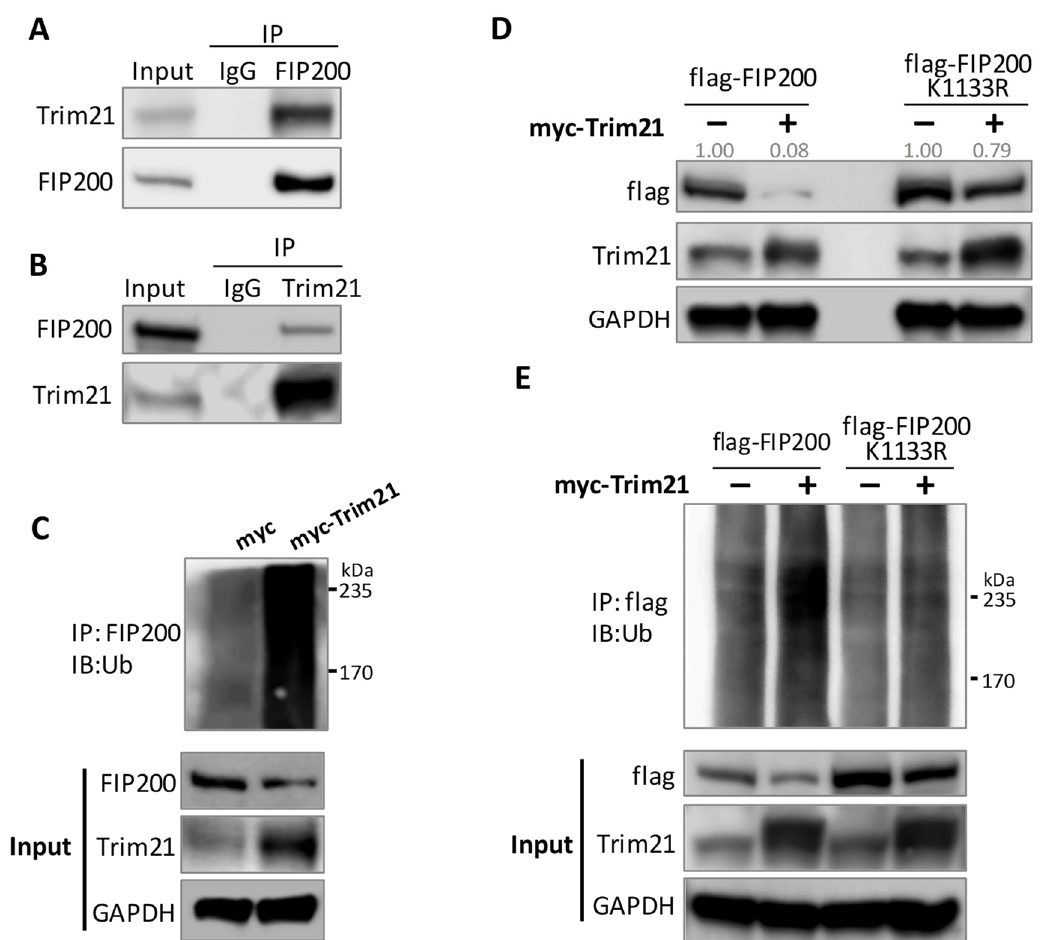
Figure 5. Trim21 ubiquitinates FIP200 for degradation. ( A , B ) Co-IP assay demonstrated interaction between endogenous FIP200 and Trim21. Anti-FIP200 Ab ( A ) or anti-Trim21 Ab ( B ) was used for immunoprecipitation. The mutual pulldown was detected by immunoblot. ( C ) Ubiquitination assay indicated Trim21 overexpression increased FIP200 ubiquitination level. HeLa cells were transfected with His-Ub and indicated plasmids. ( D ) Effect of the K1133R mutation on Trim21-induced FIP200 degradation was determined by immunoblot. HeLa cells were transfected with indicated plasmids. Here, a 3-fold amount of flag-FIP200 plasmid was transfected compared to the amount of K1133R mutant. Flag-FIP200 and K1133R mutant were quantified and normalized to GAPDH. ( E ) Ubiquitination assay showed that K1133R mutation reduced FIP200 Trim21-mediated ubiquitination. HeLa cells were transfected with His-Ub and indicated plasmids.